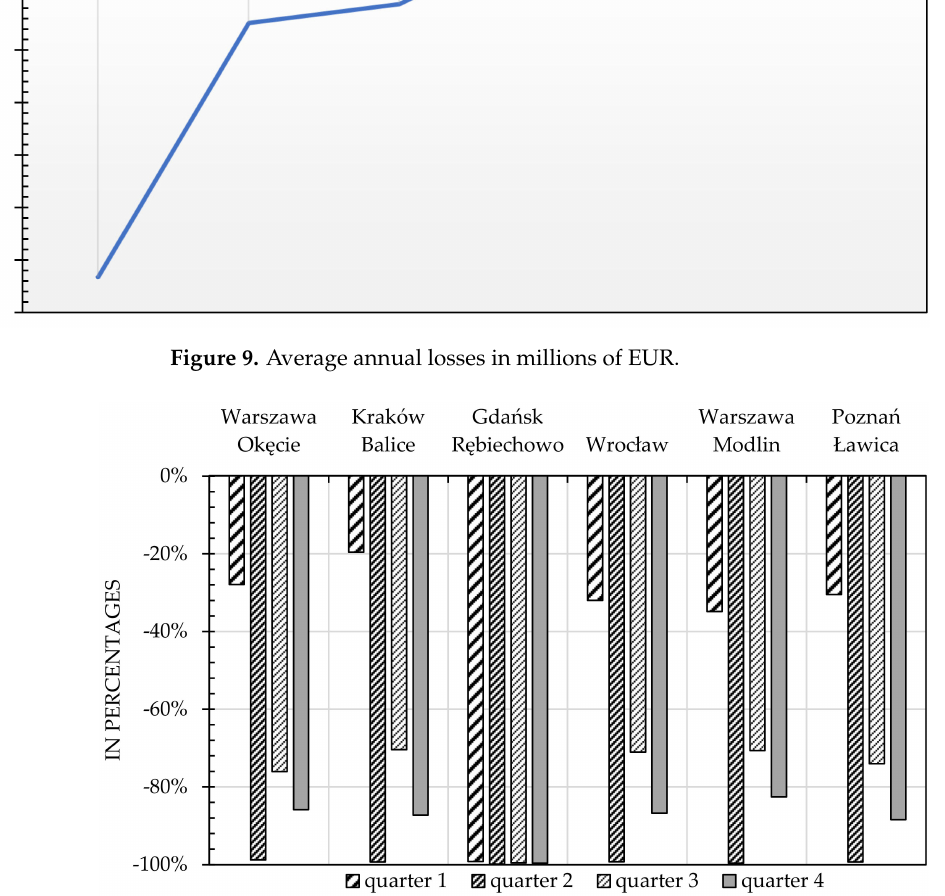
Figure 10. Average annual losses in